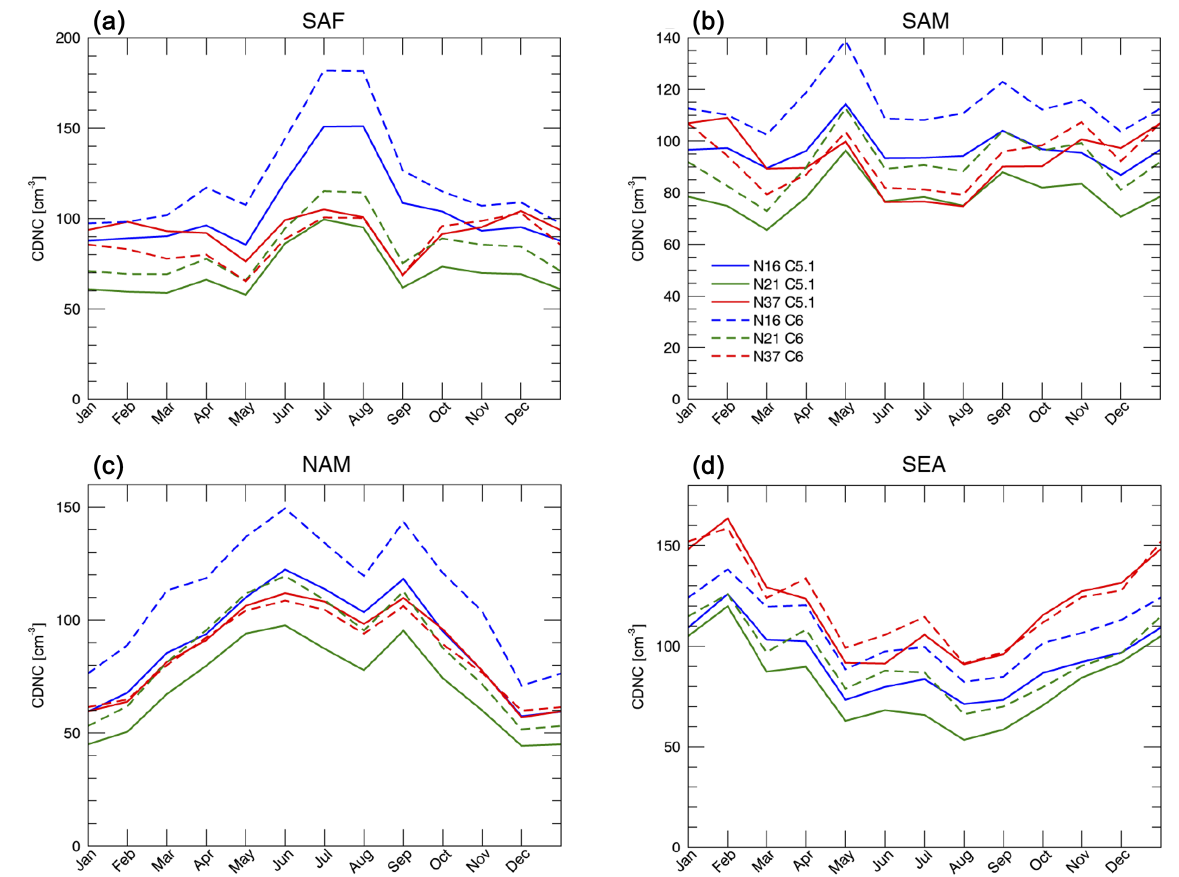
Figure 8. Annual CDNC cycle plots for the (a) southern African, (b) South American, (c) North American, and (d) Southeast Asian